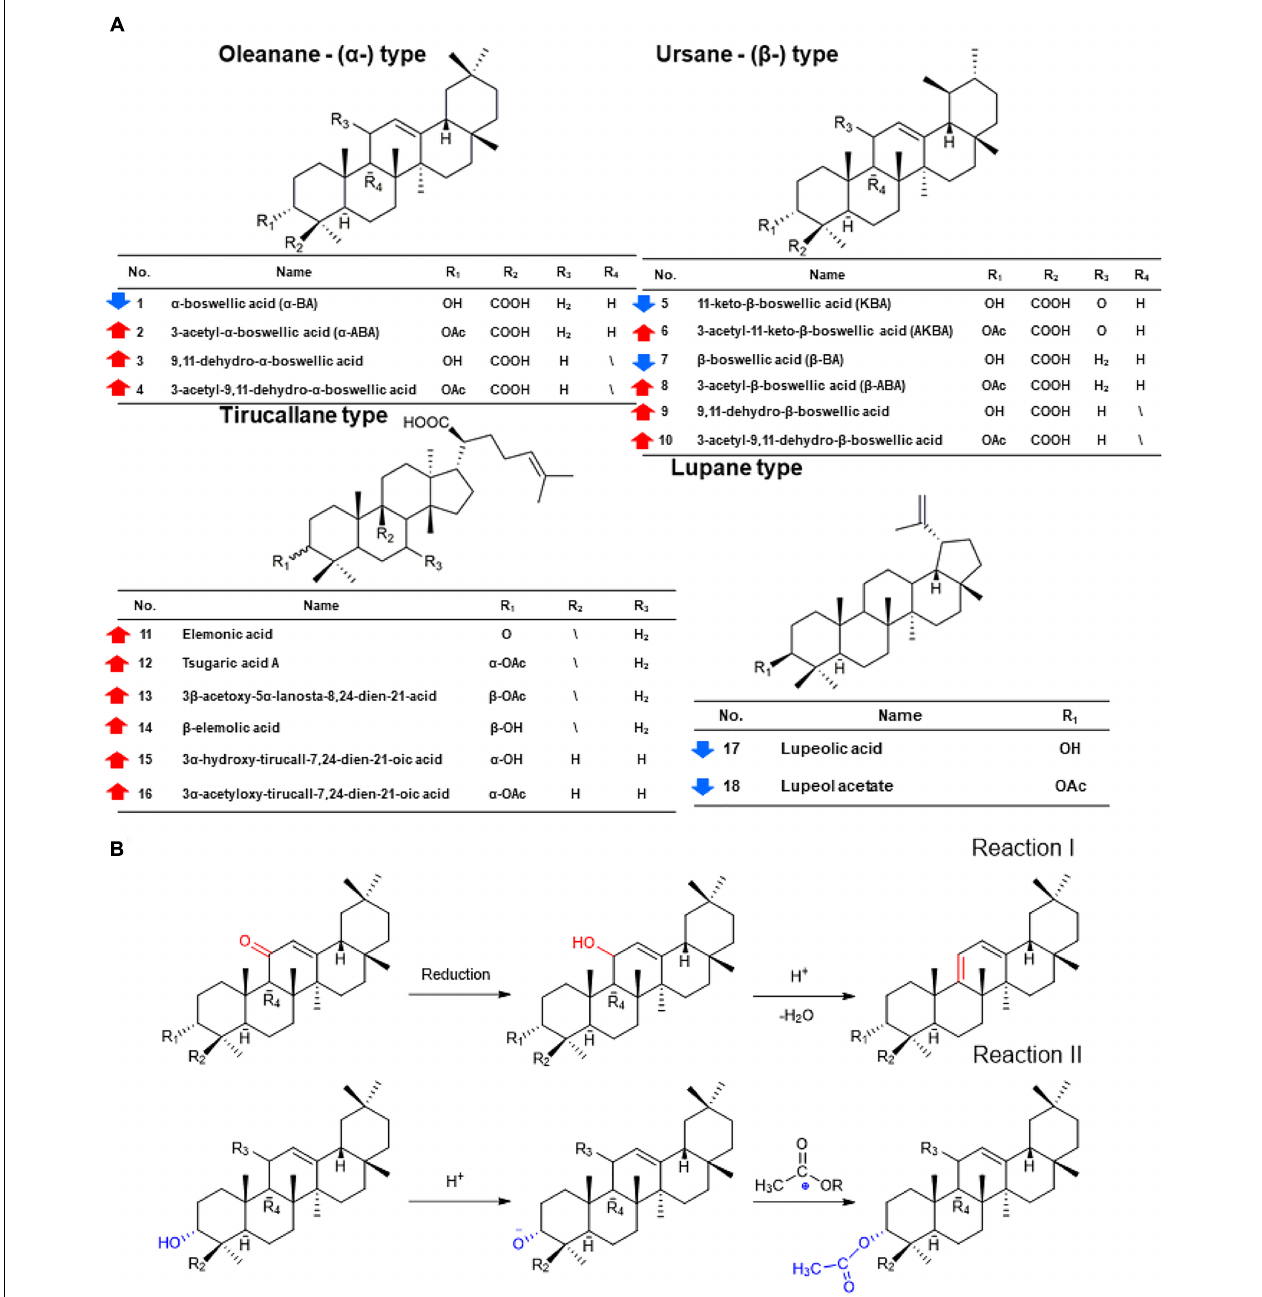
FIGURE 2 | The chemical changes of frankincense and processed frankincense and the underlying regulation of Paozhi-perturbed metabolic reactions. (A) Structures and content changes of 18 potential biomarkers of frankincense and processed frankincense ( an increase; represents a decrease). (B) Two underlying regulations of Paozhi-perturbed metabolic